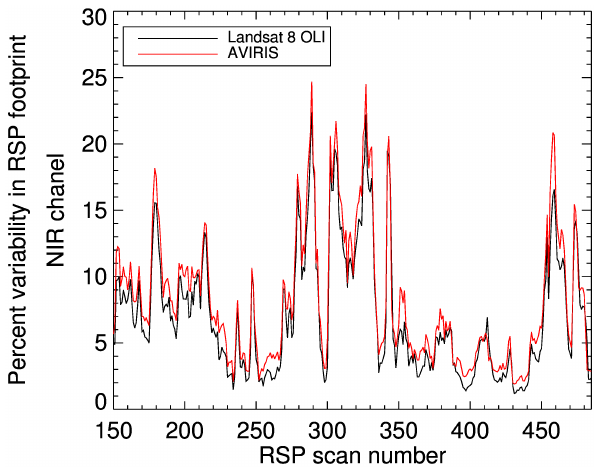
Figure 9. The ratio difference in spectral radiance between OLI and AVIRIS is used to calculate a correction curve. The multispec- tral points (circles) are interpolated to the spectral location of each AVIRIS channel (shown as